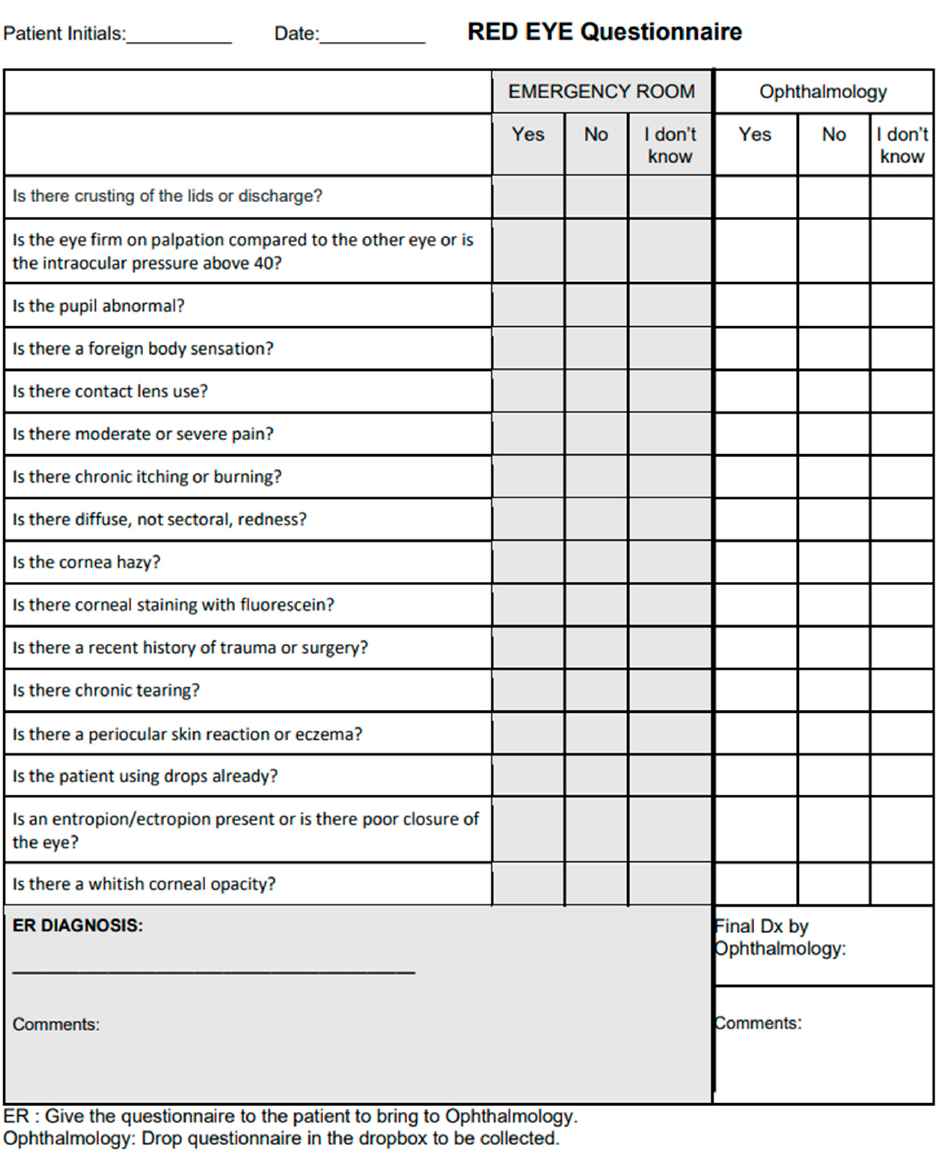
Figure 2. Questionnaire including all possible questions of the Pickle red eye algorithm.